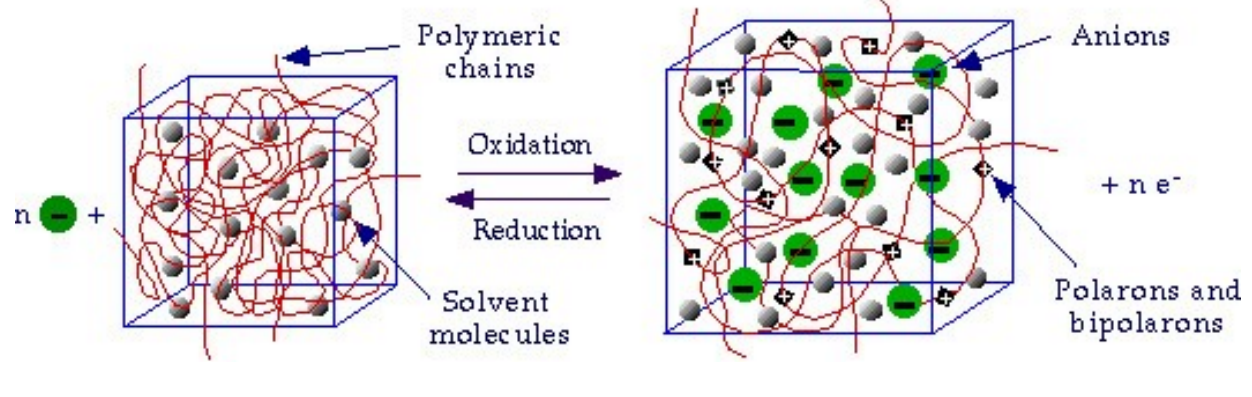
Figure 4. Schematic representation of the reversible volume change associated with the electrochemical reactions of polypyrrole in electrolytes (adopted from Reference [4] with kind permission from Springer Science and Business Media